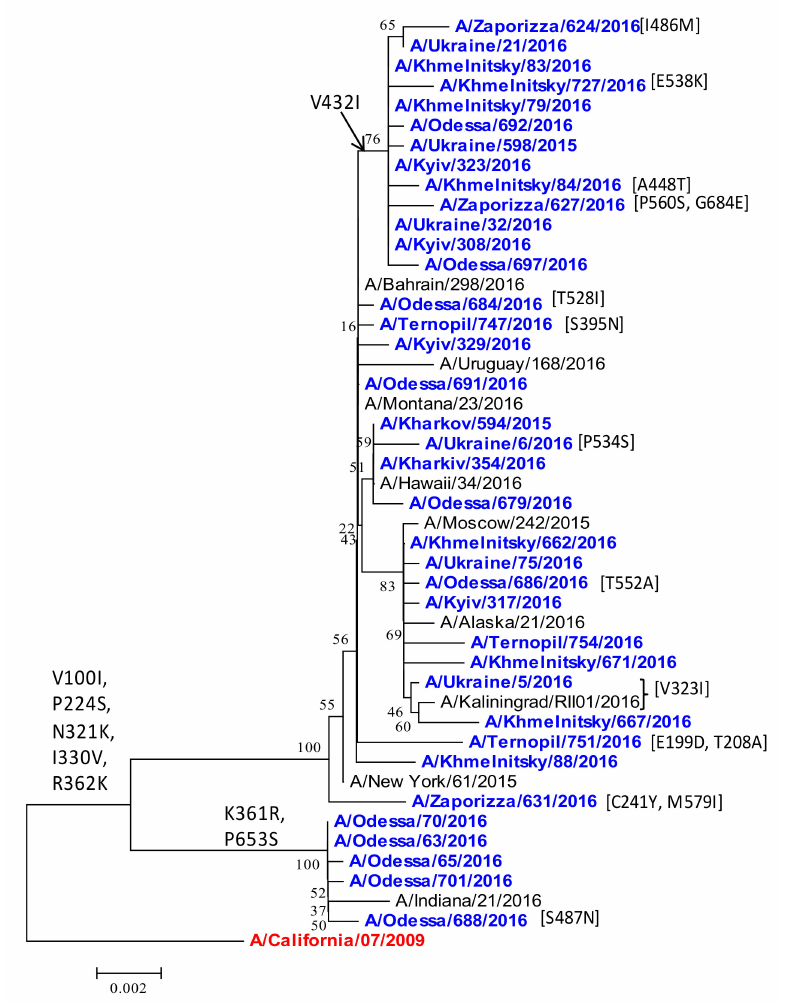
Figure 10. Phylogenetic comparison of A(H1N1)pdm09 influenza virus PA from the 2015/16 season. PA nucleotide sequences were analyzed by NJ method, Kimura 2-parameter model, with 1000 boot- strap replications. The Ukrainian 2015/16 isolates (blue), reference strains (black), and the vaccine strain